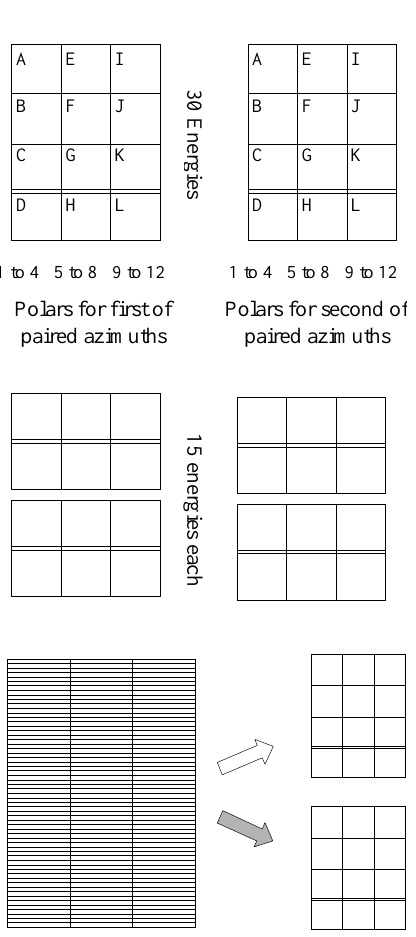
Figure A1. Mapping Basic Segment data to 8x8 images for each sweep mode Fig. A1. Mapping basic segment data to 8 × 8 images for each sweep mode. PEACE software constraints were so tight that a test to de- termine whether or not rescaling should be used could not be